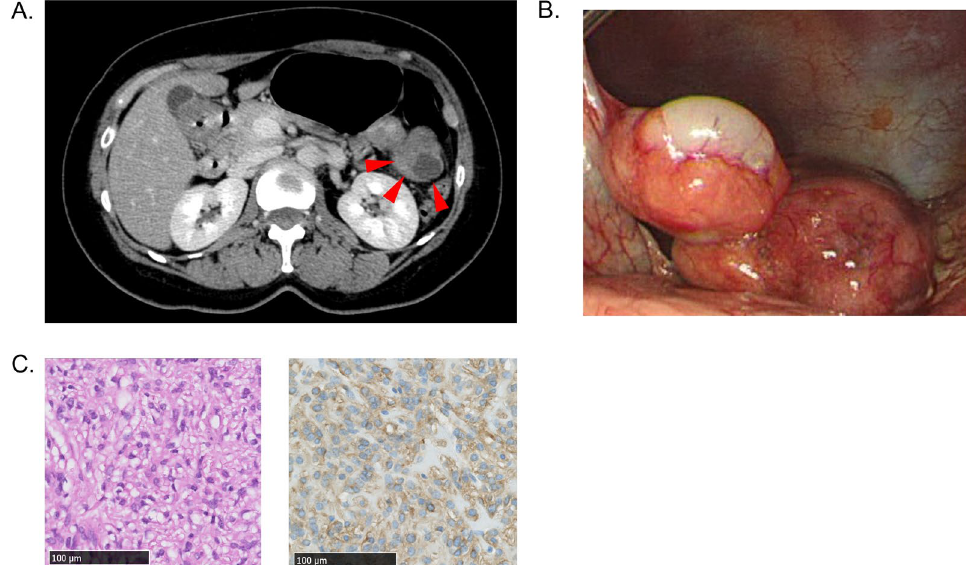
Fig. 1 Perioperative patient information. A Abdominal computed tomography at pre-operation. B Intraoperative findings. C Hematoxylin and eosin staining ( 400) and immunohistochemical staining for KIT/CD117 ( ×